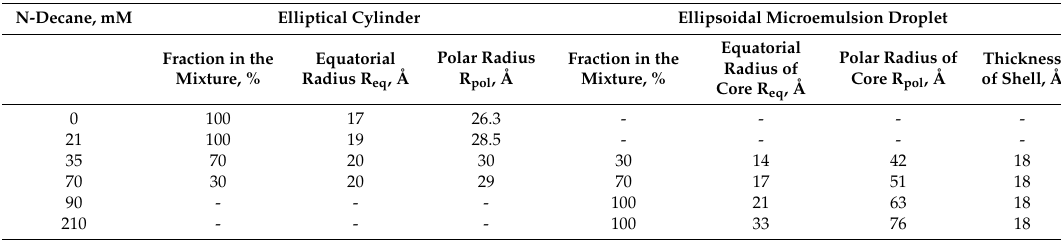
Table 1. Parameters of aggregates formed in 117 mM C8TAB and 78 mM potassium oleate aqueous solutions in the presence of di ff erent n-decane concentrations obtained from SANS data. N-Decane, mM Elliptical Cylinder Ellipsoidal Microemulsion